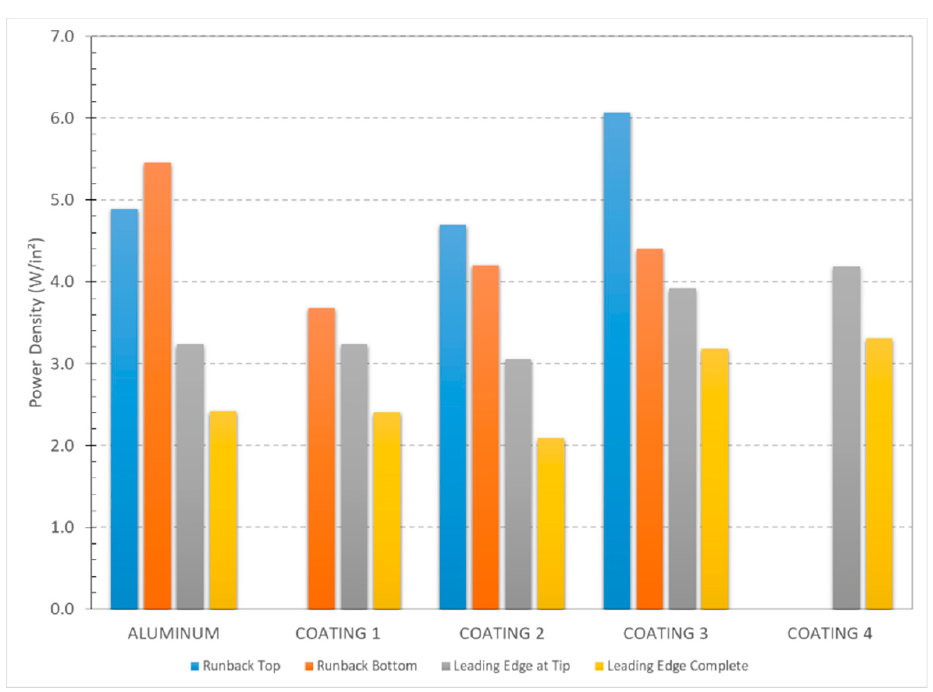
Figure 10. Power density obtained during anti-icing tests at − 7.5 °C measured when ice accretion is first initiated at different positions on the blade.